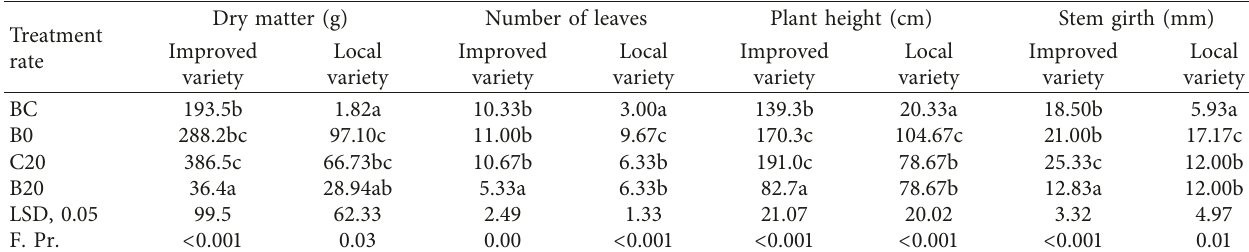
Table 6: Effects of biochar and/or compost applications on the plant growth performance of maize crop (local and improved varieties) grown on the Cape Coast soil over 40-day